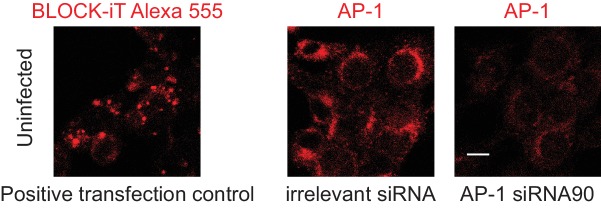
siRNA transfection controls.Confocal images of B12 mouse cell line transfected with BLOCKIT ALEXA FLUOR RED OLIGO positive control of transfection (left) and short interfering RNAs (siRNAs) pre-designed by Thermofisher (right): Stealth siRNA MSS273190 (here referred siRNA90) used to silence adaptor-related protein complex AP-1, mu subunit one gene, and Stealth RNAI NEG CTL HI GC negative control siRNA. AP-1 compartment was visualized by staining with AP-1γ mAb followed by anti-rabbit F(ab')2-FITC. Data are representative of at least two independent experiments. Scale bar: 10 μm.